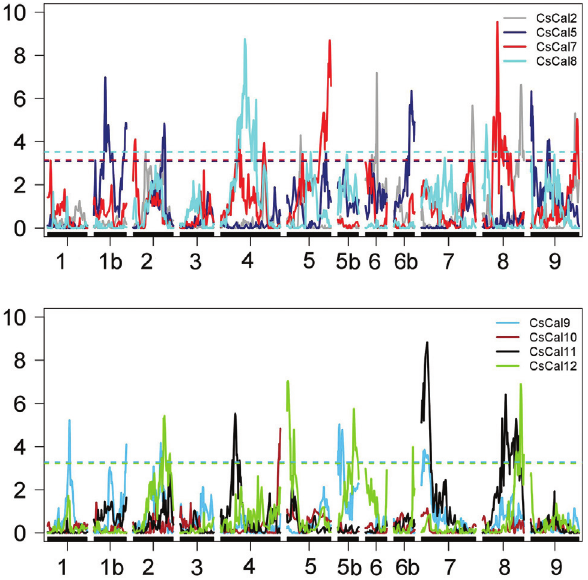
Figure 7 - Detection of eQTL in the P. trifoliata linkage map related to the expression of the CscalS genes evaluated. Y-axis: LOD; X-axis: